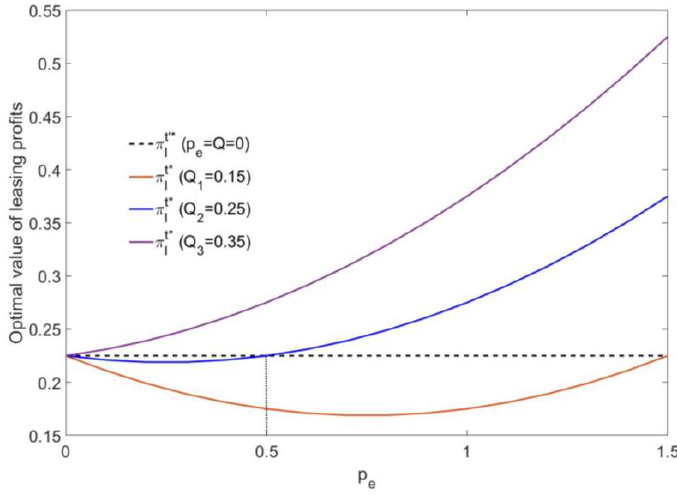
p on the optimal leasing profit. Figure 5. The effect of Figure 5. The effect of p e on the optimal leasing e